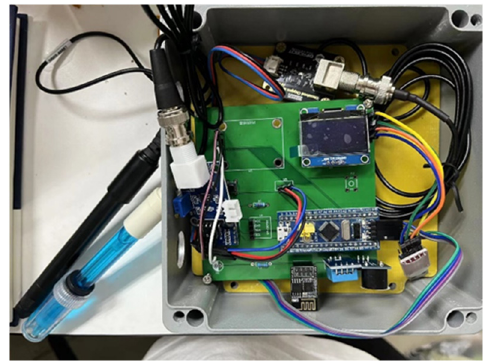
Figure 7. Physical picture of data acquisition node and transceiver.